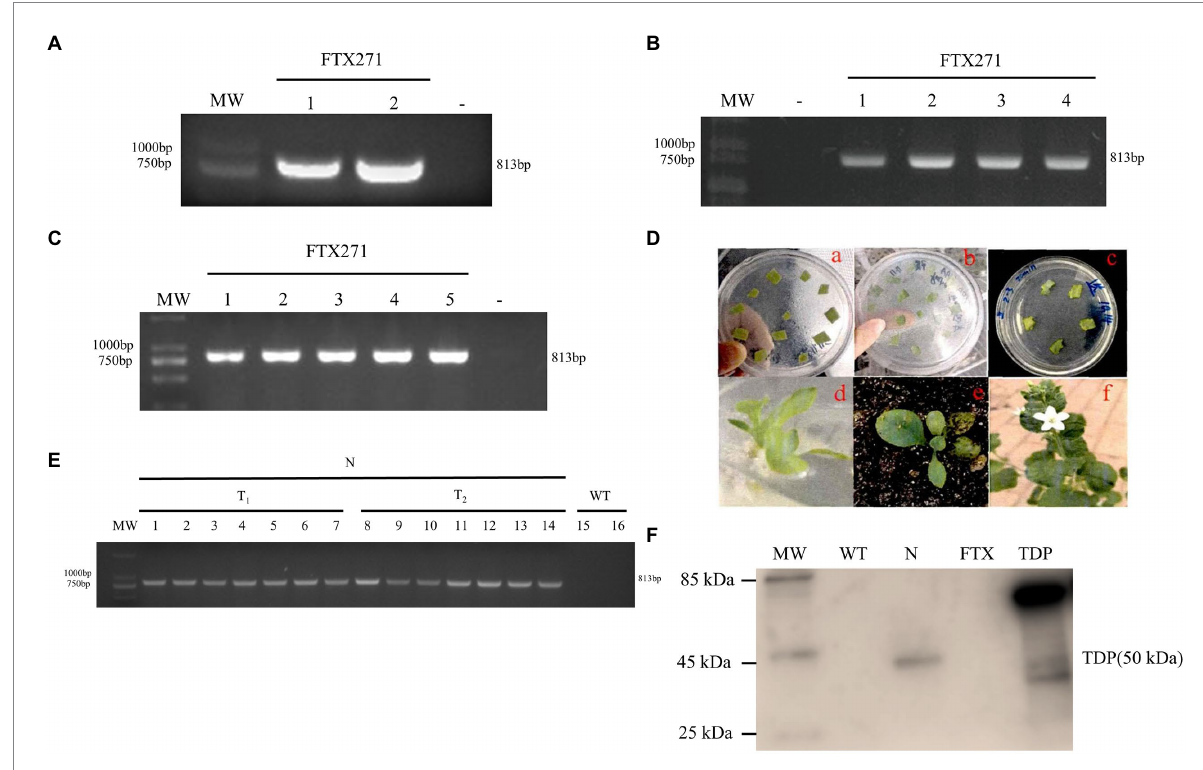
FIGURE 1 Construction and Validation of FTX271 transgenic tobacco. (A) Agarose gel analysis of the cDNA amplification result of the FTX271 gene by PCR. (B) PCR analysis to determine the insertion of pUC-T- FTX271 into E. coli DH5a. (C) PCR analysis of the heat-shock transformation of the pROKII- FTX271 vector to Agrobacterium GV3101. (D) Transformation of tobacco by the Agrobacterium-mediated leaf disc method. The experimental process was as follows: (a) predifferentiation; (b) coculture; (c) selective culture; (d) elongation and rooting; (e) hardening in a greenhouse; (f) transgenic tobacco. For A, B and C, “-” represents the negative water control. (E) FTX271-transferred positive verification, WT: wild-type tobacco plants served as the negative control. N: transgenic tobacco. (F) Western blot analysis of the expression level of FTX271 in tobacco. Protein extracts from leaves were immunoblotted and probed with antibodies, and protein sizes are shown on the